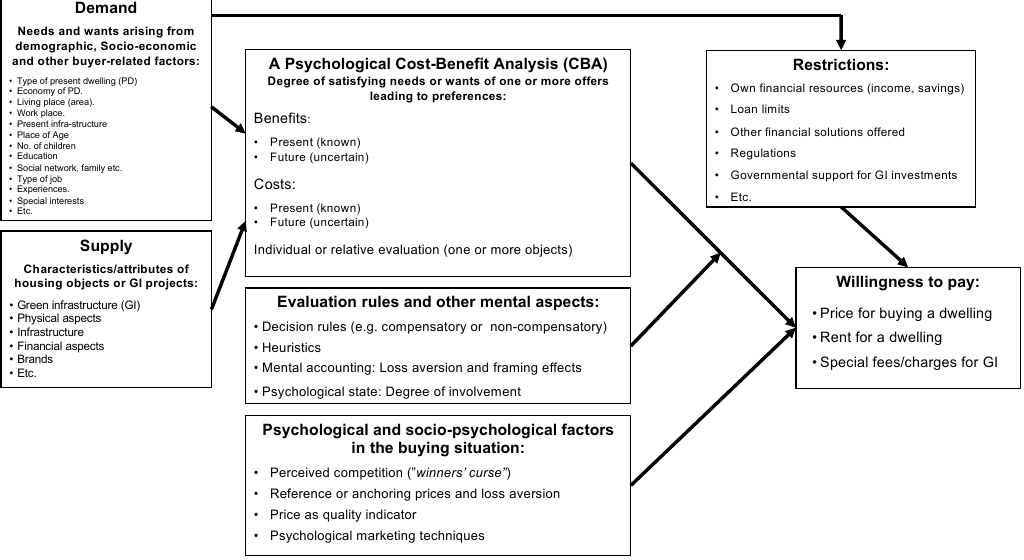
Figure 1 . Willingness for Pay for Residential Property and Green Infrastructure (source: Authors).